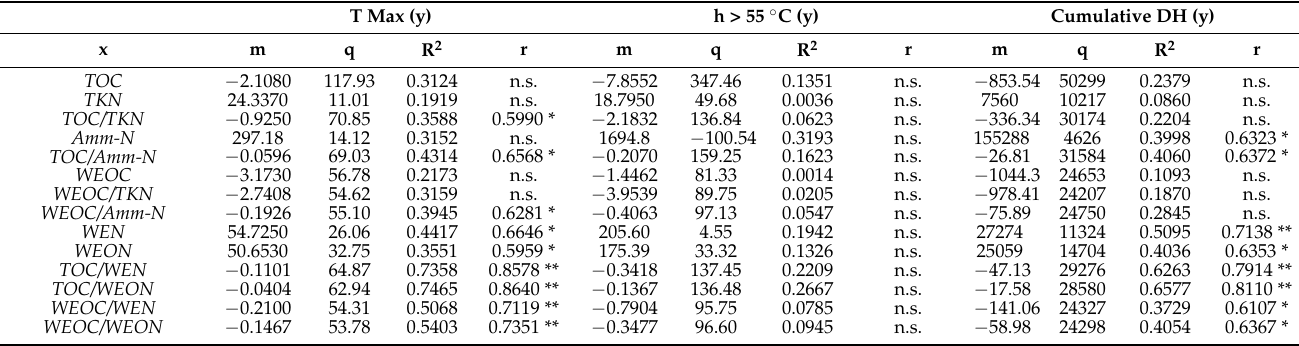
Table 6. Linear regression between chemical parameters of the mixtures and temperature evolution during the active phase of